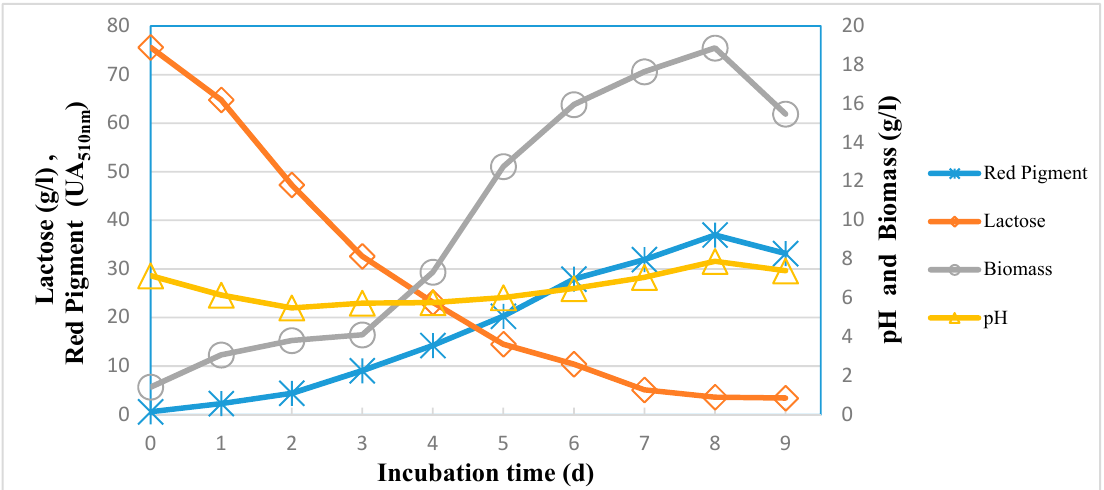
Figure 7. Simultaneous hydrolysis and fermentation (SHF) profiles of mycelial growth of M. purpureus CMU 001, red pigment synthesis, lactose consumption, and pH under the optimum conditions (Fermentation conditions: 30 °C, 8 days, 200 rpm, pH 7.0, 5 g/L MSG, 75 g/L lactose). The standard deviation of each experimental point ranged from 1.5 to 4.8.